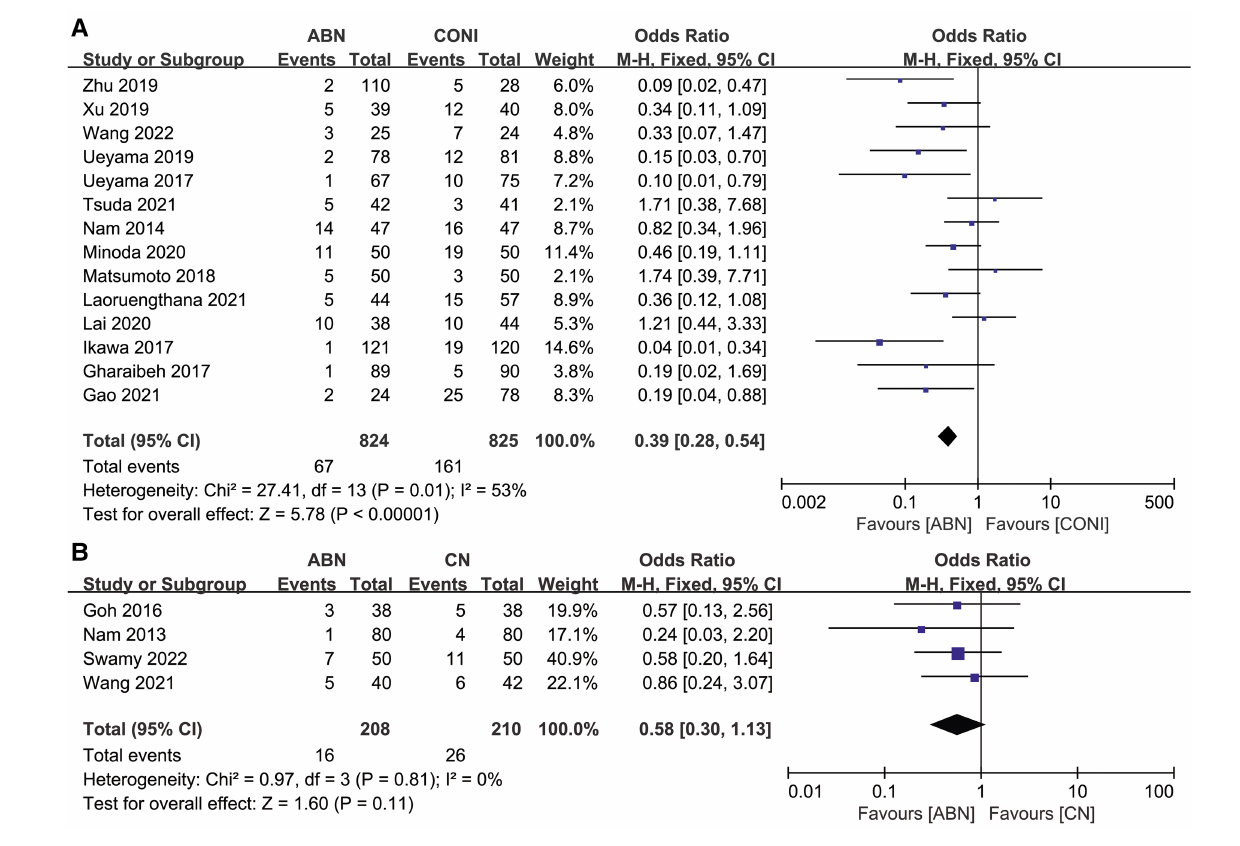
FIGURE 6 Forest plot of CFA outliers. ( A ) Accelerometer-based navigation (ABN) system vs. conventional instrumentation (CONI); ( B ) ABN system vs. computer navigation (CN)